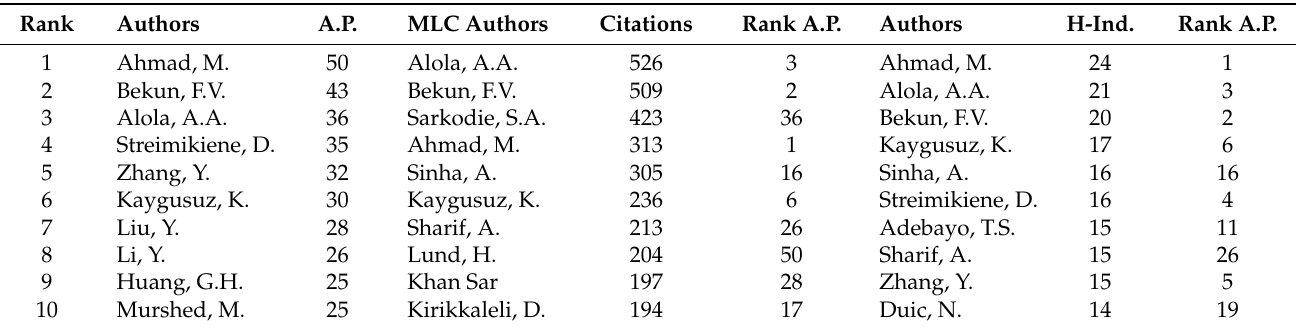
Table 3. Ranking of the top 10 most relevant